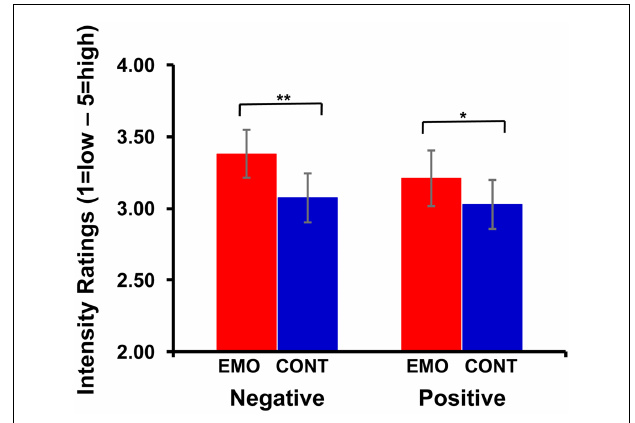
FIGURE 2 | Increased subjective re-experiencing of emotion during Emotion focus retrieval . Self-reported ratings for emotional intensity were higher in the Emotion (EMO) than in the Context (CONT) condition, for both negative (** p < 0.005) and positive (* p < 0.05) autobiographical